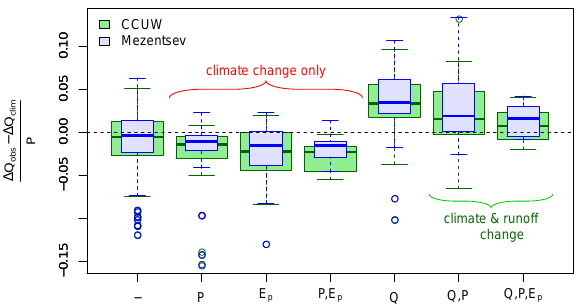
Fig. 6. Boxplot of the difference of observed and predicted annual average changes in streamflow normalised by annual average of pre- cipitation of the first period. Subsets are in accordance with the t-test classification.